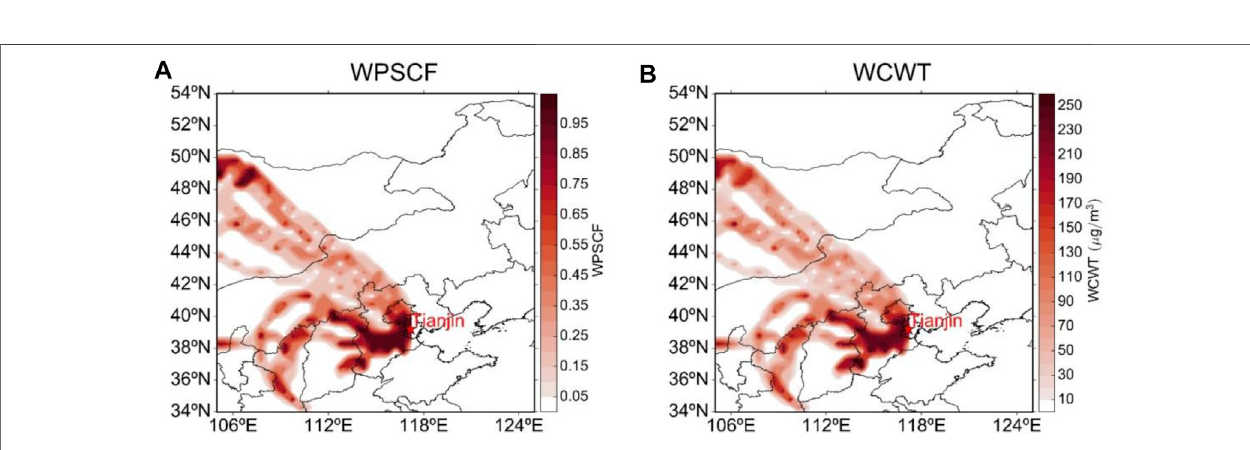
Frontiers in Environmental Science |